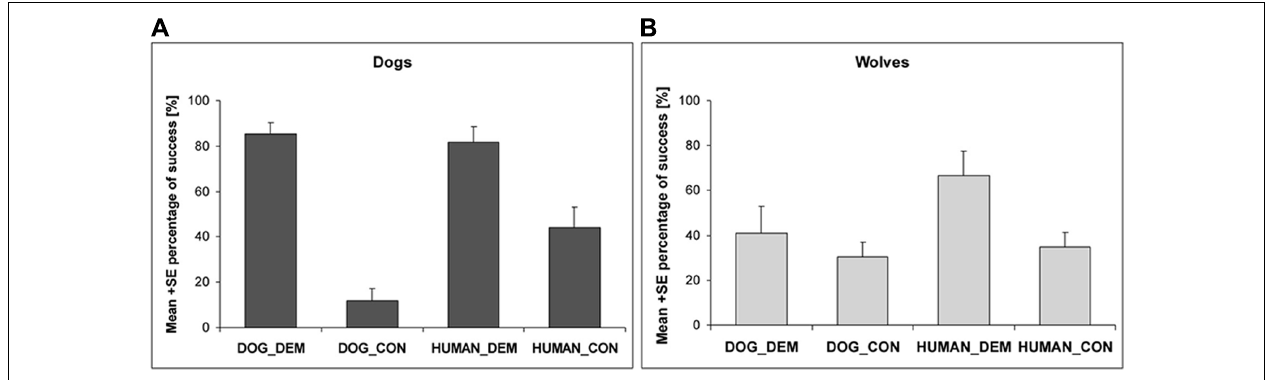
FIGURE 5 |The success of dogs (A) and wolves (B) in the dog and human demonstration (DOG_DEM and HUMAN_DEM) and control conditions (DOG_CON and HUMAN_CON).